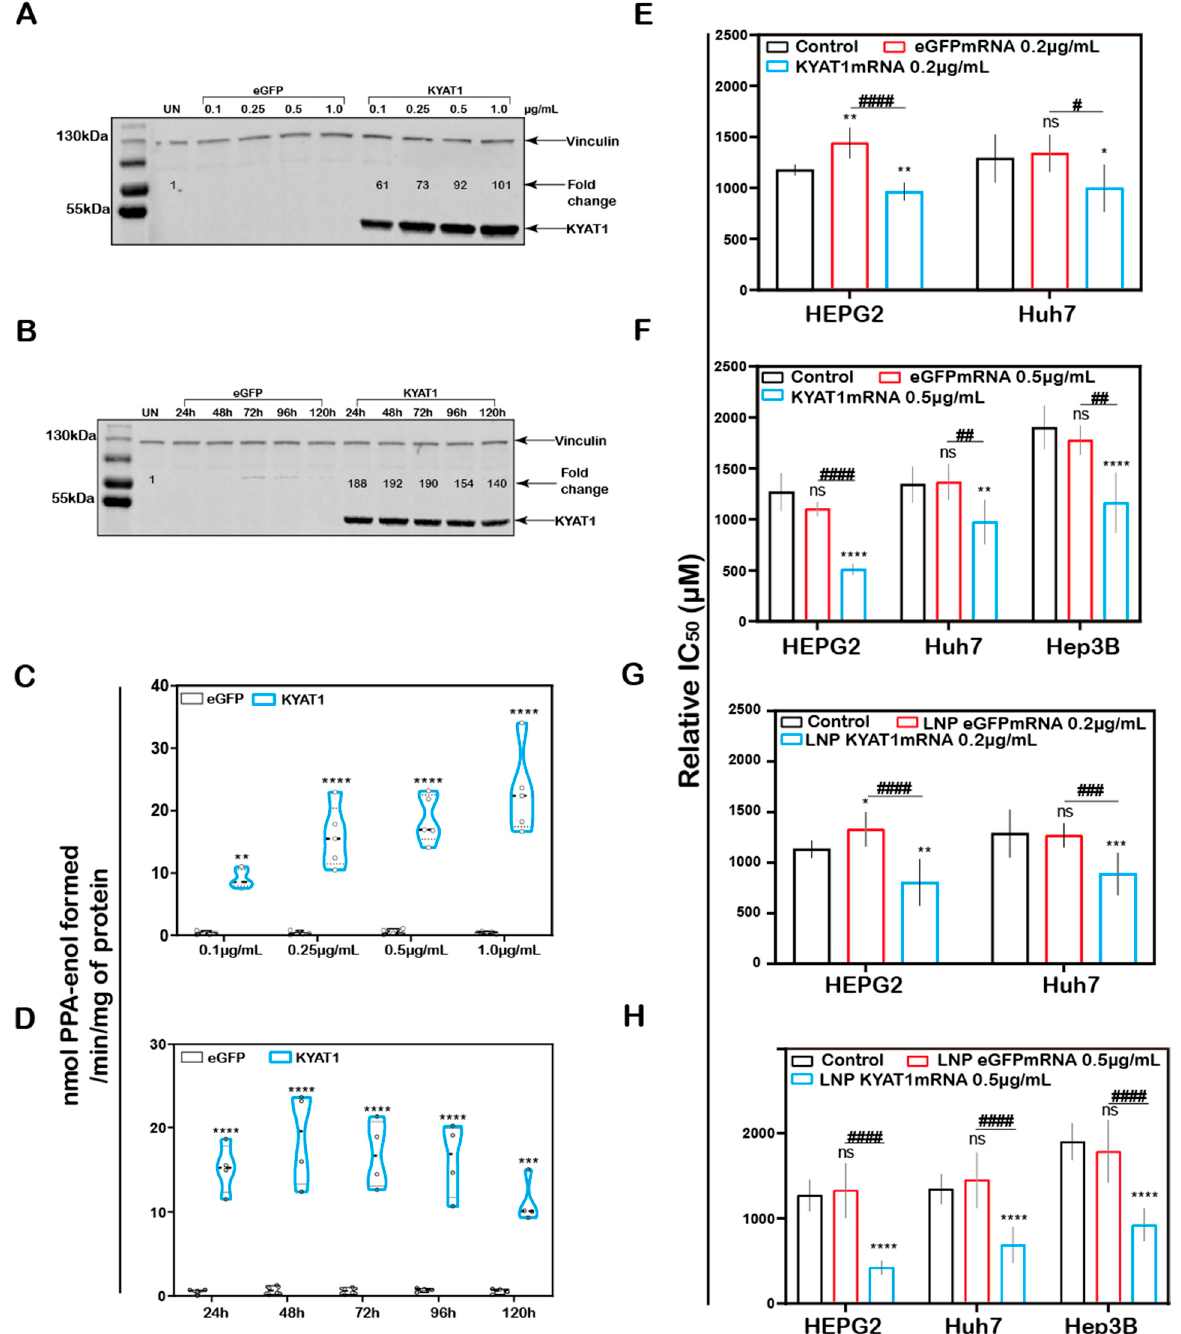
Figure 3. KYAT1 upregulation increases the efficacy of MSC cytotoxicity in HCC cell lines. Western blot showing the expression of KYAT1 in HEPG2 cells transfected with ( A ) varying concentrations (0.1, 0.25, 0.5, and 1 µg/mL) of KYAT1mRNA or eGFPmRNA encapsulated in LNP at 48 h. ( B ) About 0.5 µg/mL of LNP encapsuled KYAT1mRNA or eGFPmRNA at different time points (24, 48, 72, 96, and 120 h). ( C ) Transamination activity of KYAT1 was determined for samples at varying concentration at fixed time ( n = 5) and ( D ) fixed concentration (0.5 µg/mL) at varying time ( n = 4). Dose- dependent effect of MSC at 72 h in HCC cell lines transfected with ( E ) mRNA-encoding KYAT1 or eGFP (0.2 µg/mL), ( n = 6–11) ( F ) mRNA-encoding KYAT1 or eGFP (0.5 µg/mL) ( n = 5–11), ( G ) LNP-encapsulated KYAT1 or eGFP mRNA (0.2 µg/mL) ( n = 6–11) and ( H ) LNP-encapsulated KYAT1 or eGFP mRNA (0.5 µg/mL) ( n = 6–11). ( A , C ) KYAT1 48KDa and Vinculin 124KDa used as loading control, UN = un-transfected control. ( E – H ) eGFPmRNA and non-transfected cells were used as a control with respective concentrations as mentioned above. Graph represents mean ± SD, statistical analysis performed with ( B , D ) unpaired t-test and ( E – H ) one-way ANOVA with 95% confidential interval followed by Tukey’s multiple comparison test (ns = not significant, * p < 0.05, ** p < 0.01, *** p < 0.001, and **** p < 0.0001 compared with control and # p < 0.05, ## p < 0.01, ### p < 0.001, and #### p < 0.0001 compared with eGFPmRNA).